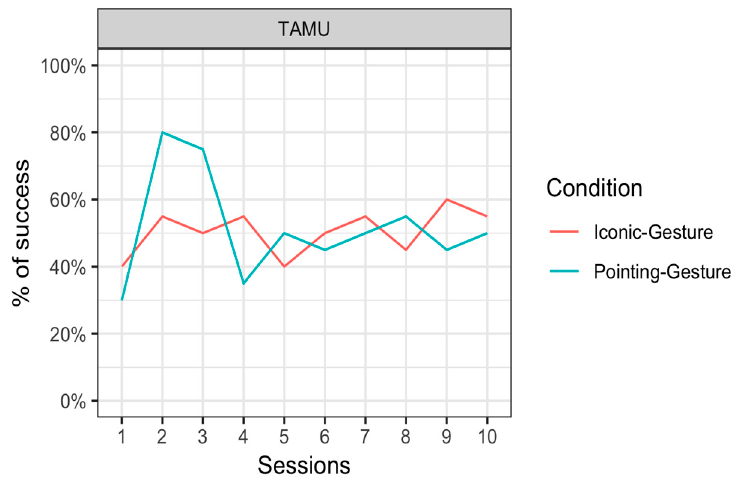
Figure 6. Percentage of successful responses (mean) of the orangutan Tamü in the Iconic–Gesture condition (pink line) and the Pointing–Gesture condition (blue line) in the 10 sessions.